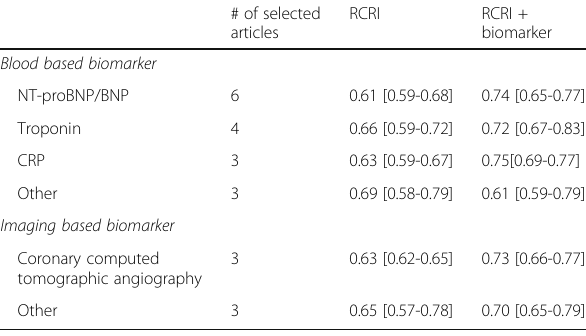
Table 1 (abstract P63). Predictive performance using c-statistic for RCRI alone versus RCRI models with